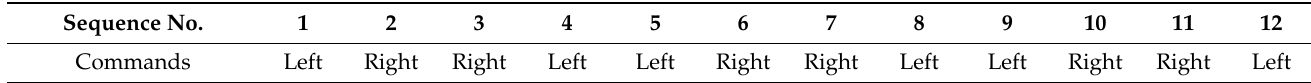
Table 3. The experimental task of the real-time MI-based BCI.